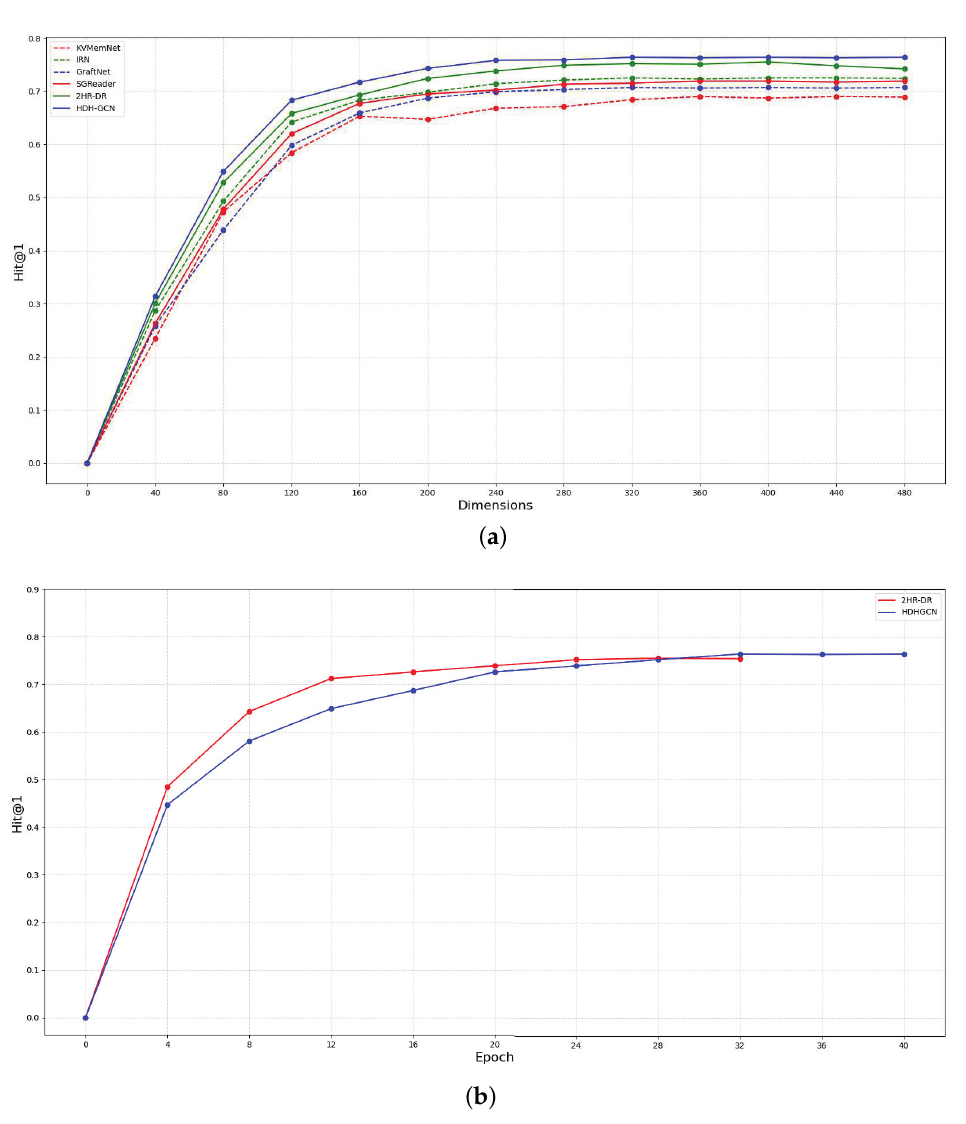
Figure 3. ( a ) Hit@1 over different embedding sizes of knowledge base QA models, evaluated on PQL-2H. ( b ) Hit@1 over different training epochs, evaluated on